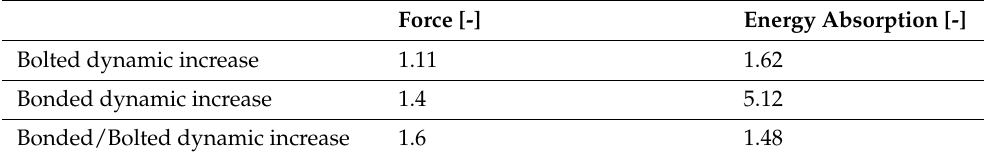
Table 4. Dynamic increase for every type of joint.